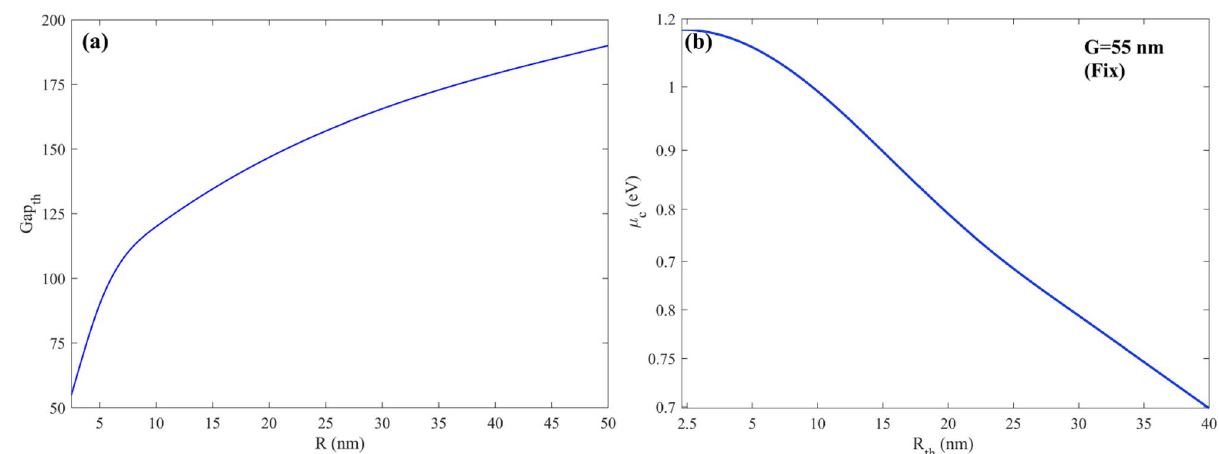
Figure 15. Threshold gap ( a ) and threshold chemical potential of graphene nanoribbons ( b ) as a function of sorted nanoparticle with radii 2.5–50